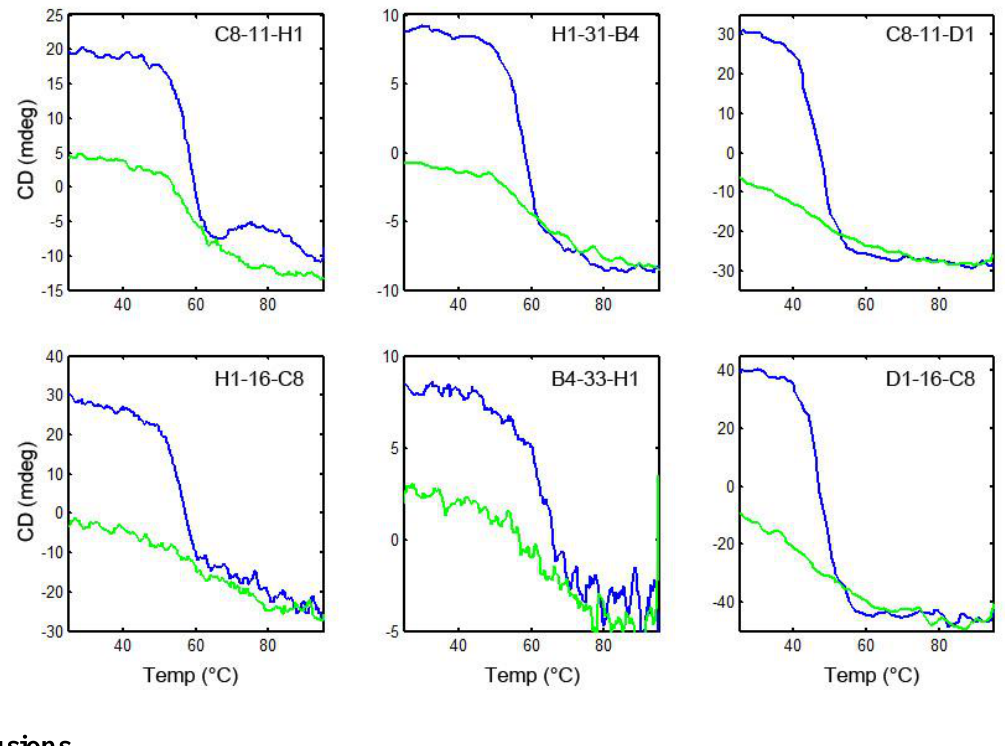
Figure 5. Circular dichroism of linked constructs. Representative constructs in which sdAb are joined in each orientation are shown. Blue curve is heating, and green is